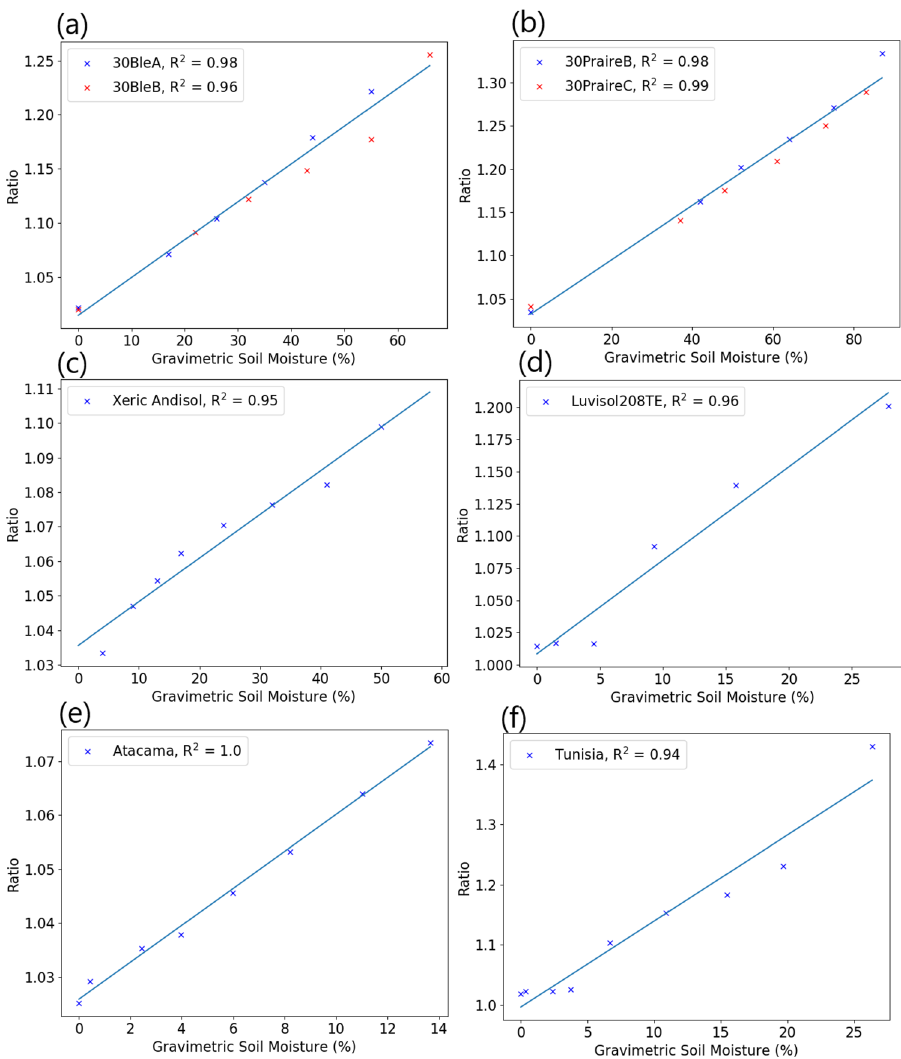
Figure 6. Calibration curves created for datasets provided by 21